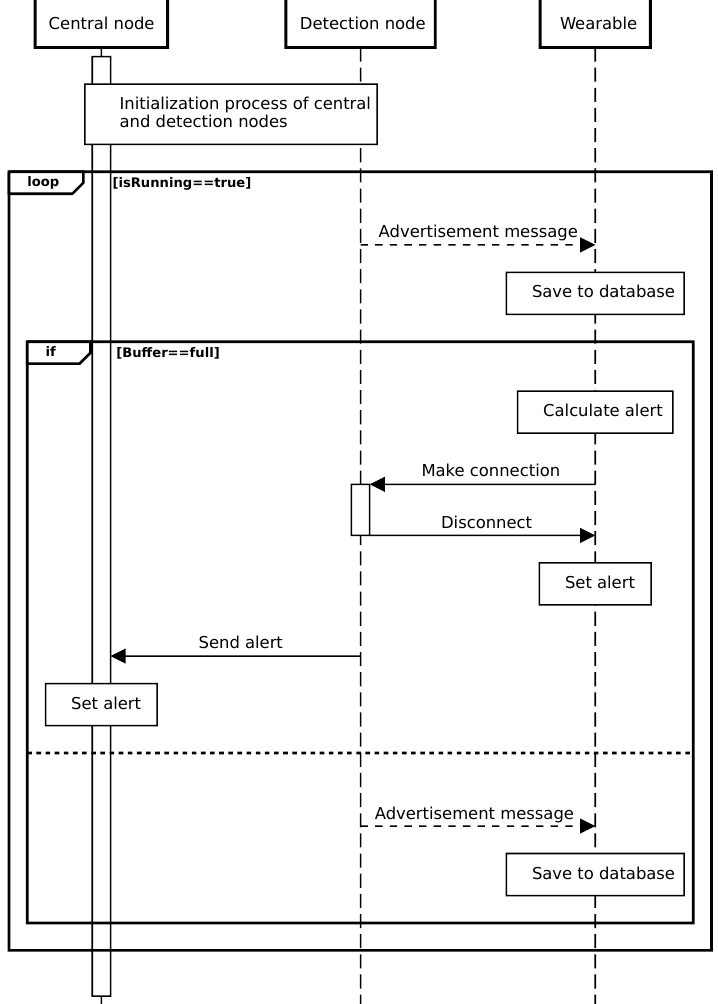
Figure 4. Sequence diagram of the designed system starting from the point when the wearable is